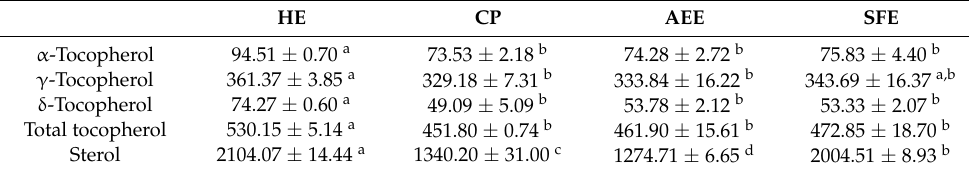
Table 4. The tocopherol and sterol content (mg/kg) of X. sorbifolia oil. HE CP AEE SFE α